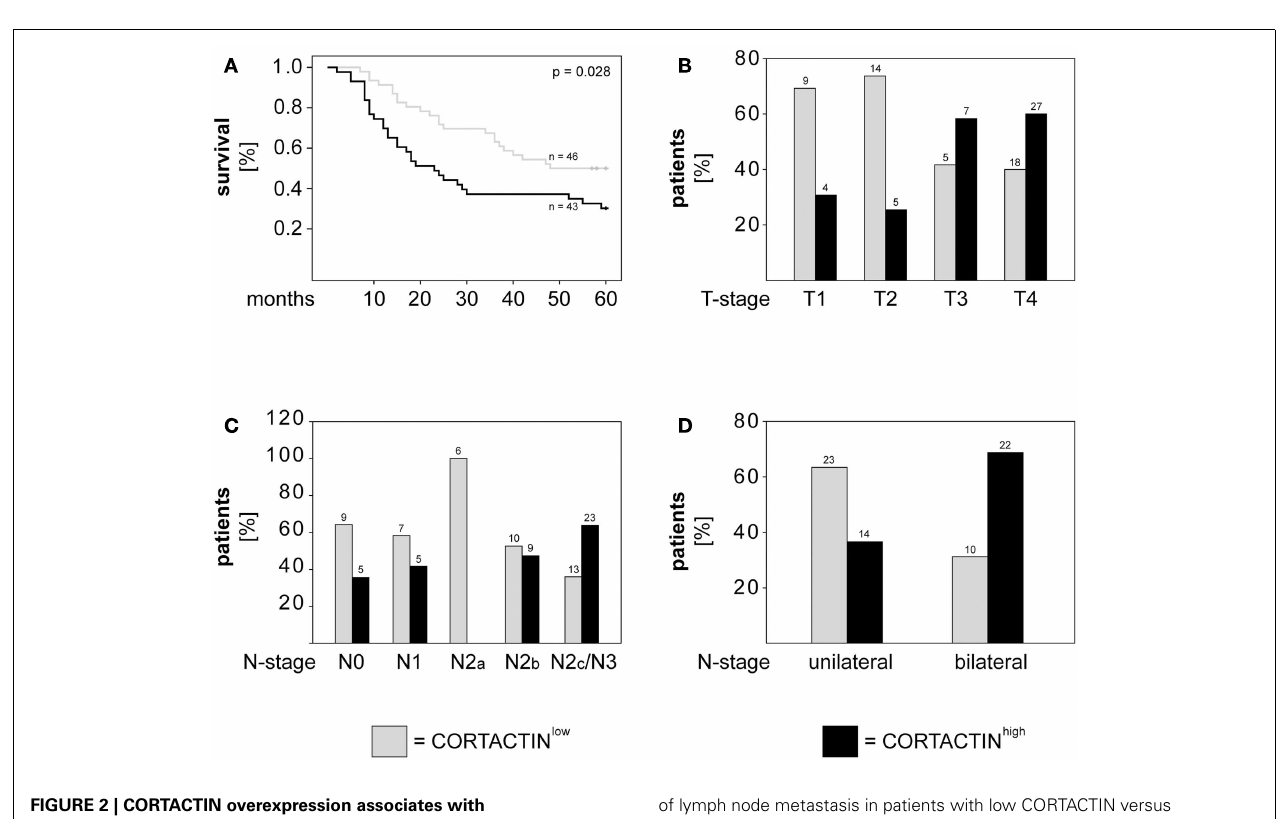
FIGURE 2 | CORTACTIN overexpression associates with advanced disease and poor clinical outcome in orohypopharynx carcinoma patients. (A) Kaplan–Meier 5-years survival curves were plotted for patients with low versus high tumoral CORTACTIN expression and statistical analysis was performed with the log-rank test. Graphical depiction of (B) T-stage, (C) N-stage, and (D) laterality